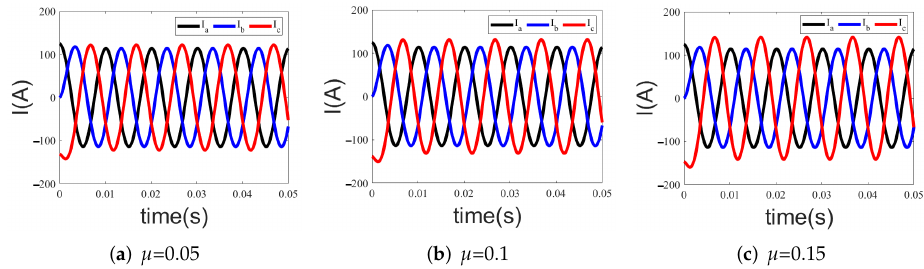
Figure 8. Three phase current when C − phase fault. ( a ) µ = 0.05 ( b ) µ = 0.1 ( c ) µ = 0.15.